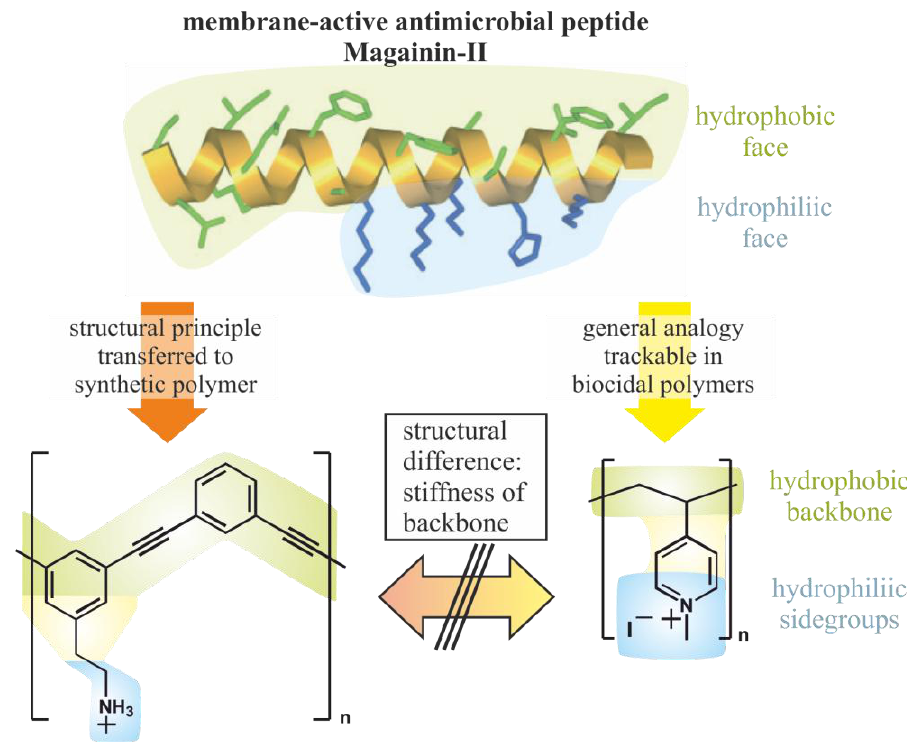
Figure 4. Biocidal polymers as antimicrobial